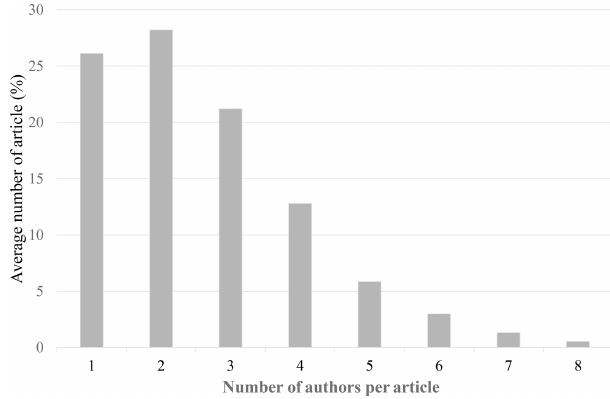
Figure 2. Average number of authors per article between 1981 and 2017.